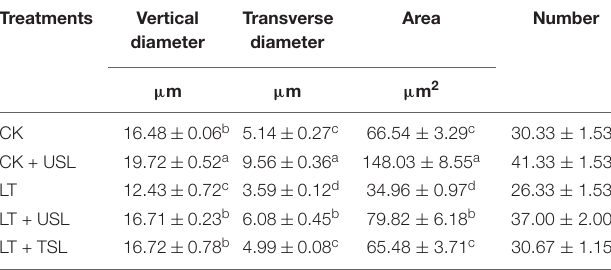
TABLE 3 | Effects of USL on the characteristics of the tomato stomatal apparatus under LT stress. Treatments Vertical diameter